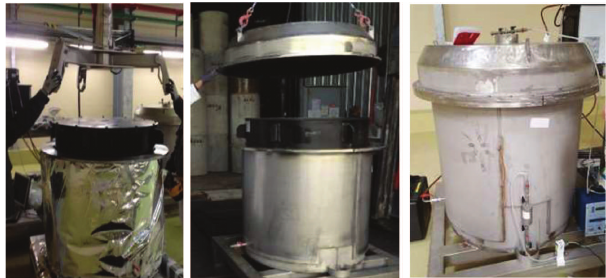
Fig. 17. 870 L FI setup in airtight enclosure (middle) and closed airflow circuit for accumulation data acquisition